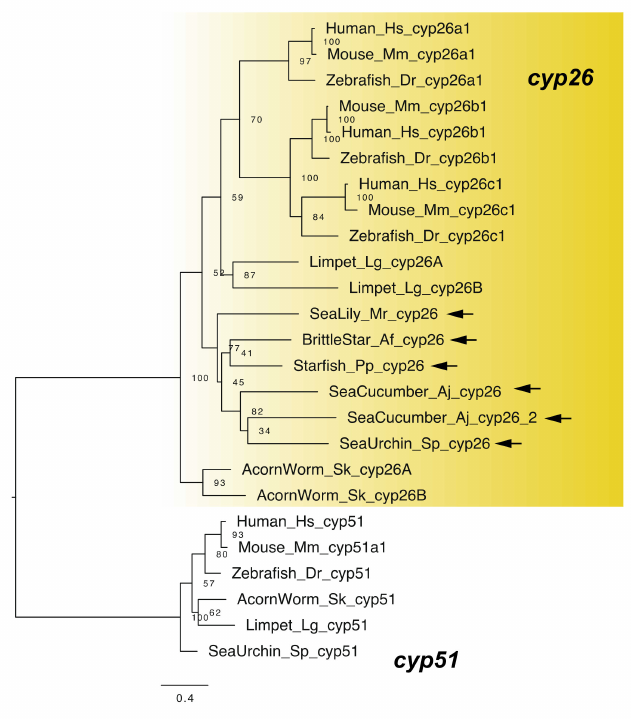
Figure 5. Maximum-likelihood phylogenetic tree for cyp genes. We retrieved the gene dataset of cyp (Table S5, Supplementary Dataset 5) and constructed phylogenetic tree as described above. In addition, construct phylogenetic tree, respectively. Yellow box and arrows, respectively, indicate cyp26 gene clade and cyp26 genes retrieved from dataset of